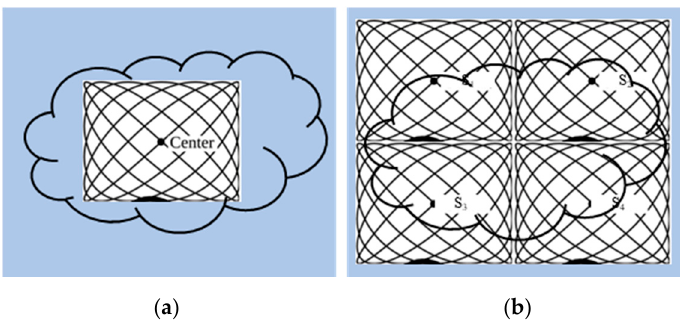
Figure 5. ( a ) The phantom cannot be covered by a single patch; ( b ) the phantom can be covered by multiple